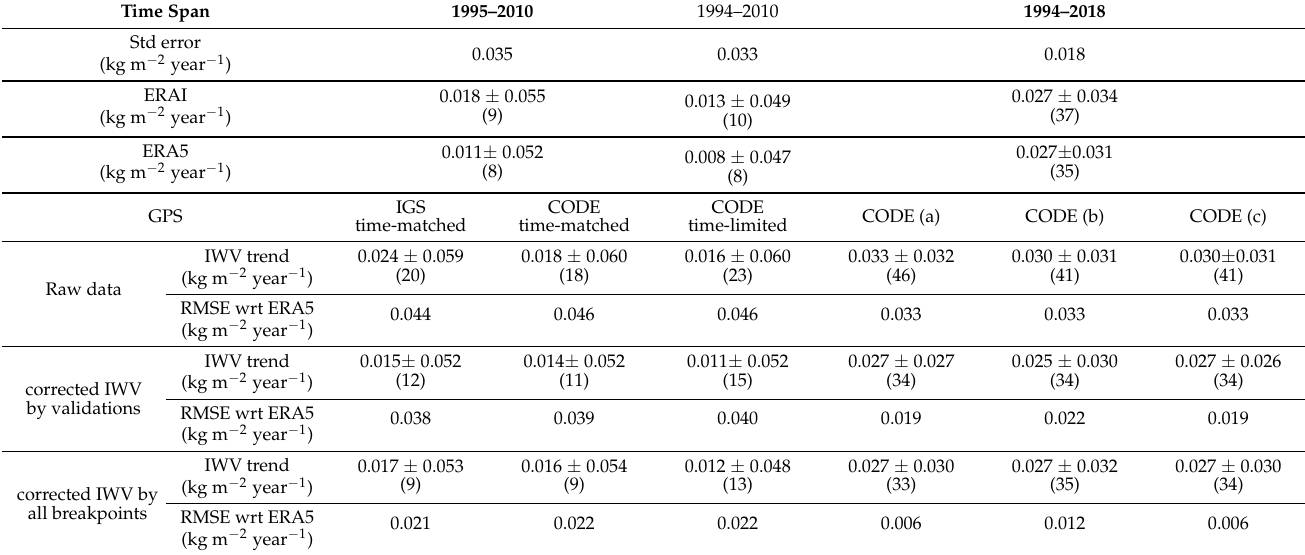
Table 3. Summary of IWV trends from various data sets used in this work. The number of stations with significant trends at level α = 0.05 is given in brackets. (a) GNSS data converted with auxiliary data from ERAI and segmentation applied the CODE—ERA5 IWV difference. (b) GNSS data converted with auxiliary data from ERA5 and segmentation applied the CODE—ERAI IWV difference. (c) GNSS data converted with auxiliary data from ERA5 and segmentation applied the CODE—ERA5 IWV